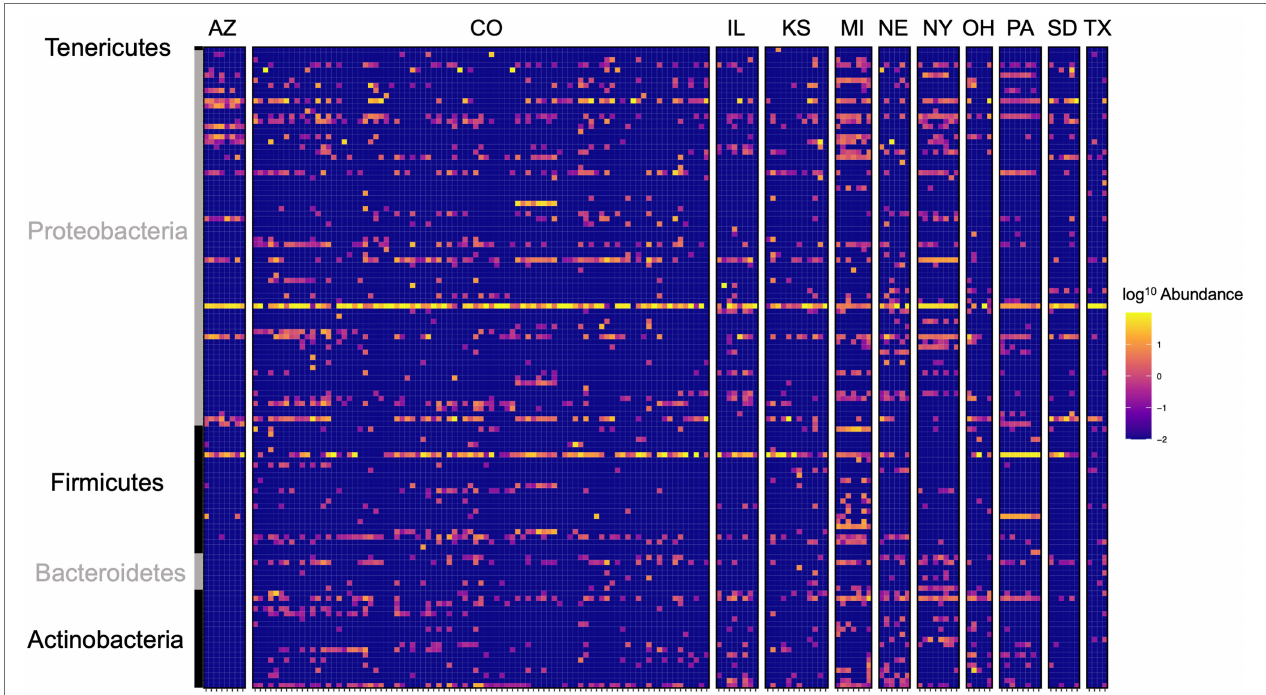
FIGURE 4 | Heat map of log 10 abundance of the top 125 most abundant ASVs in western corn rootworm (WCR) across sampling locations in the United States. Each row represents a single ASV and each column represents one beetle microbiome collected from one site within the state. Colorado consisted of multiple sampling sites. Family level grouping of ASV are provided on the right of the figure. Data presented with Wolbachia removed from